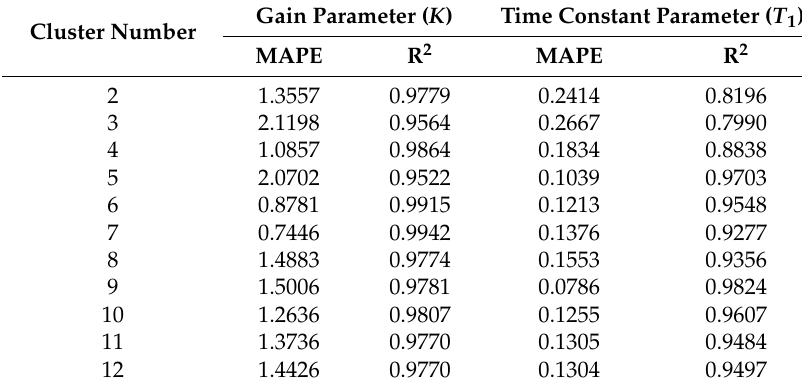
Table 3. MAPE and R 2 values with the di ff erent number of clusters for the ANFIS model (second test